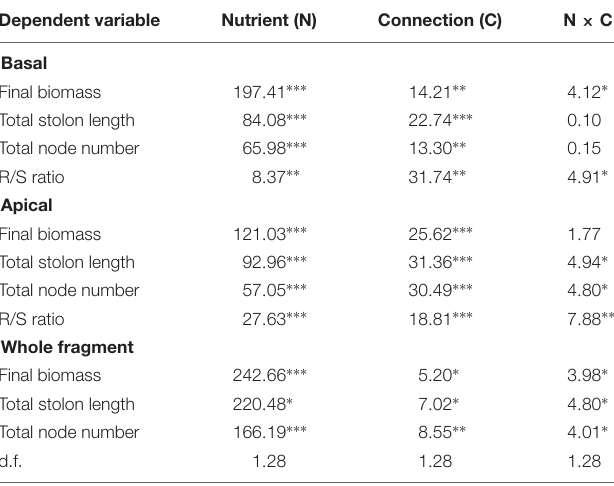
TABLE 1 | Two-way ANOVA analyses for the effects of soil nutrient and stolon connection on the growth (final biomass, total stolon length, and total